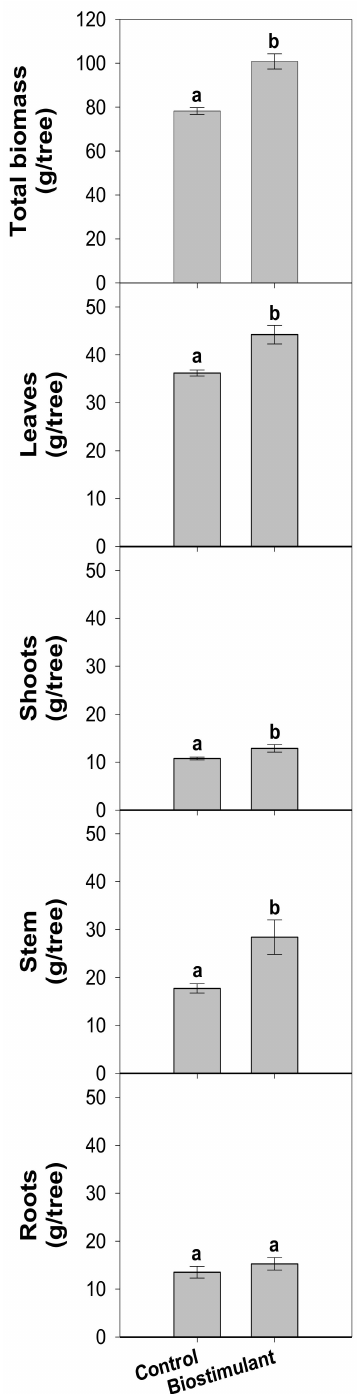
Figure 3. Total biomass (dry weight) at the end of the vegetative season and of the di ff erent components, such as roots, stem, leaves, and branches, of pot treated and control trees. Bars represent the standard error. Means accompanied by di ff erent letters are significantly di ff erent at p <